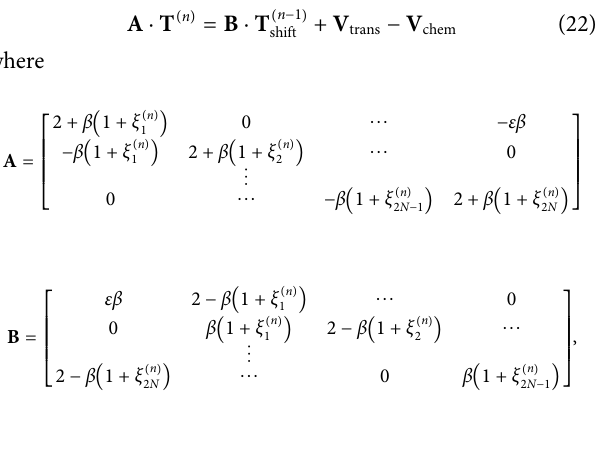
Frontiers in Energy Research |